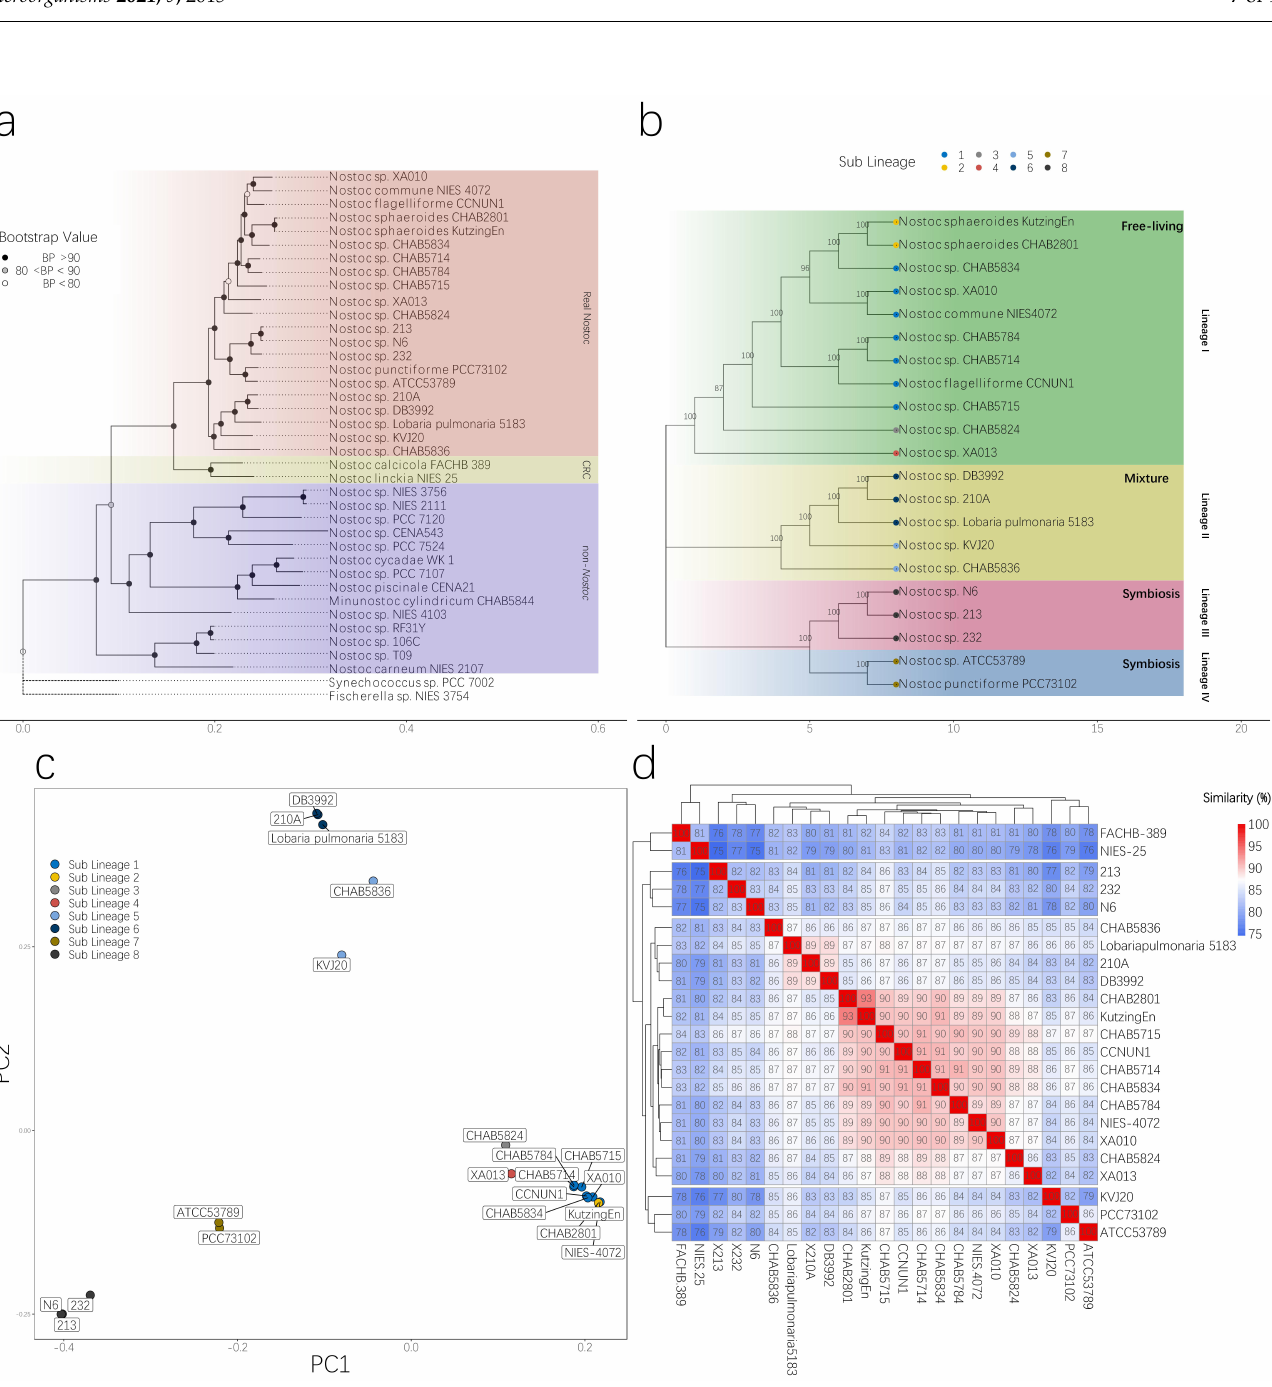
Figure 3. Phylogenetic differentiation of RNS and non- Nostoc species. ( a ). Maximum likelihood phylogenetic tree reconstruction of the core genome of 37 strains of the genome of Nostoc -like strains by using the Raxml software. A GTRGAMMA model was adopted in the analysis, and 100 bootstrap tests were performed. The number on each node represents the bootstrap value. ( b ). Nostoc was divided into four clades and marked in different colors by Bayesian analysis of population structure. ( c ). Principal component analysis of the shared SNPs among RNS genera, ( d ). Average nucleotide identity (ANI) among Nostoc and CRC strains. The color gradient shows the ANI value of each genome pair. The final analysis results were plotted using the ggplot2 v3.1.0 software package [47].